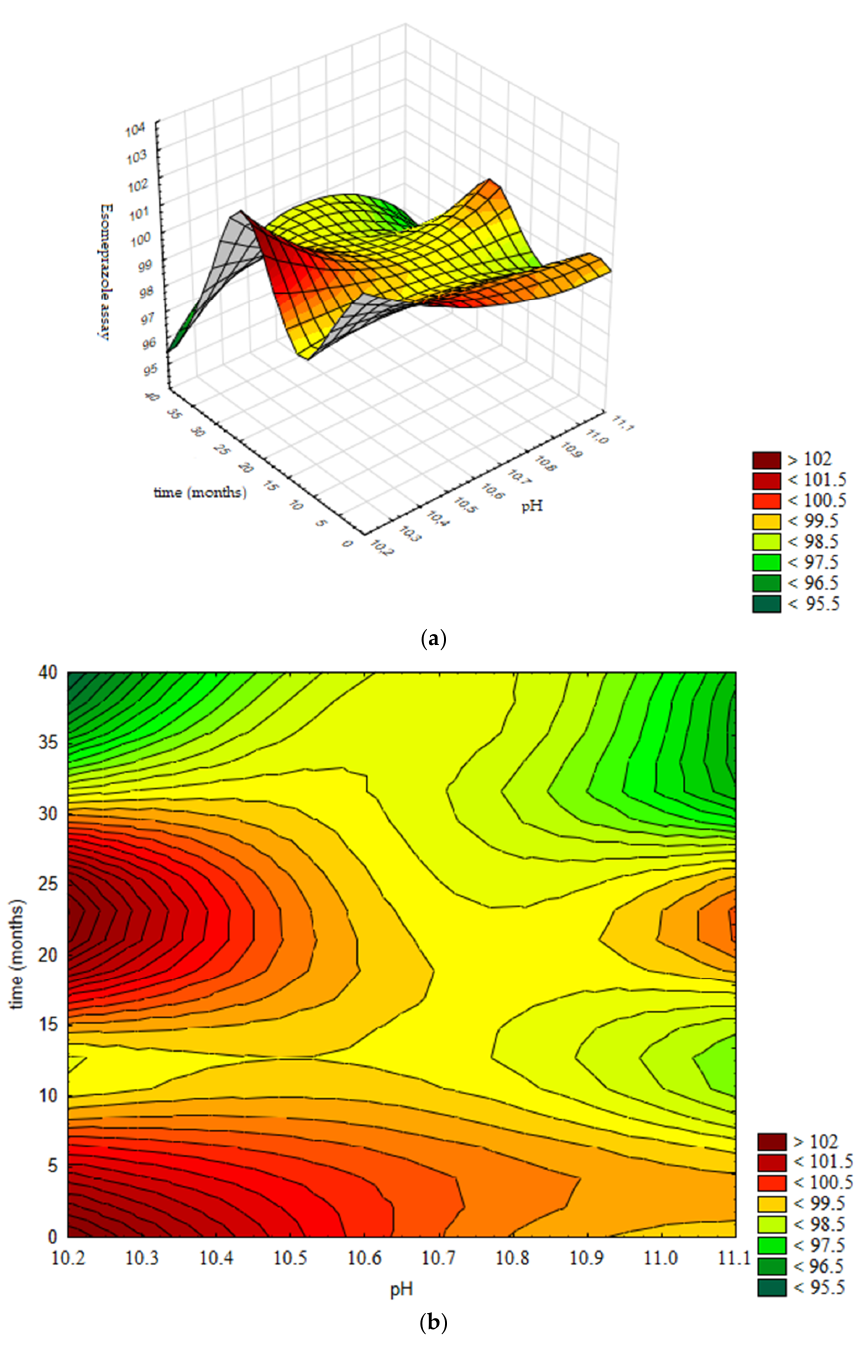
Figure 14. Influence of pH value and time on the assay of Esomeprazole: ( a ) Response surface; ( b ) Contour